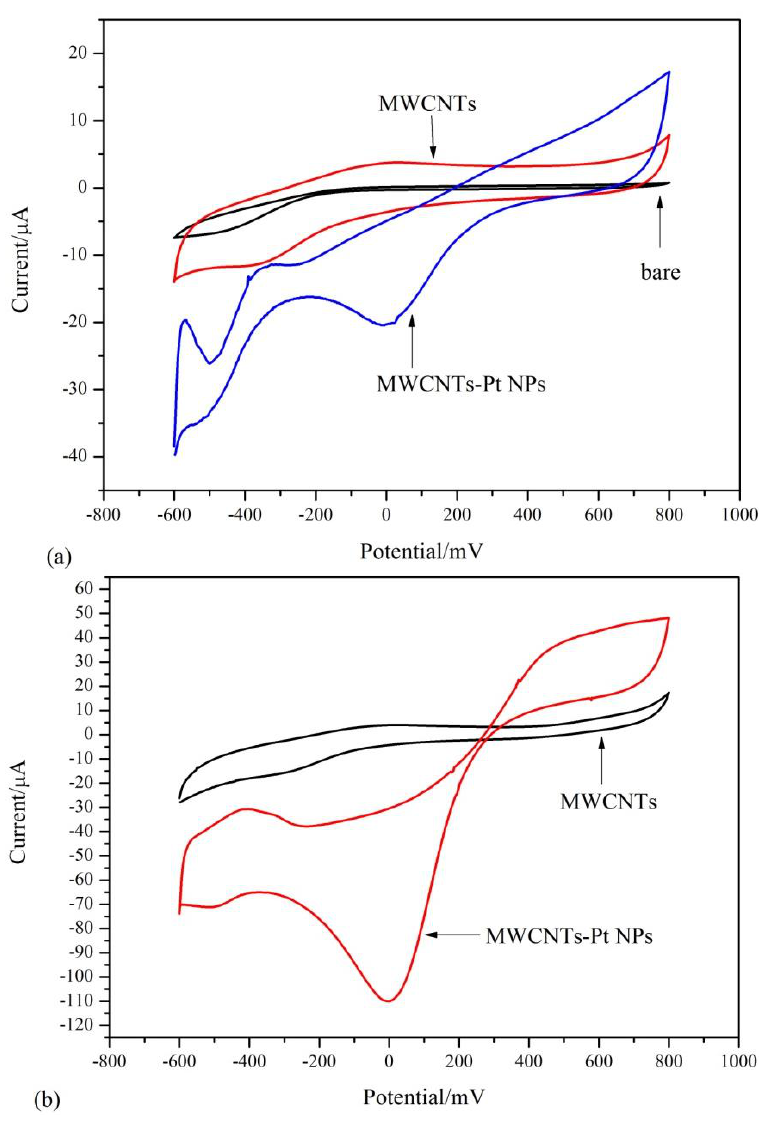
3. Cyclic voltammograms of bare Pt electrode, MWCNTs/Pt electrode. ( a ) MWCNTs/Pt NPs/Pt electrode in 0.1 M PBS without H electrode in 0.1 M PBS with H O 2